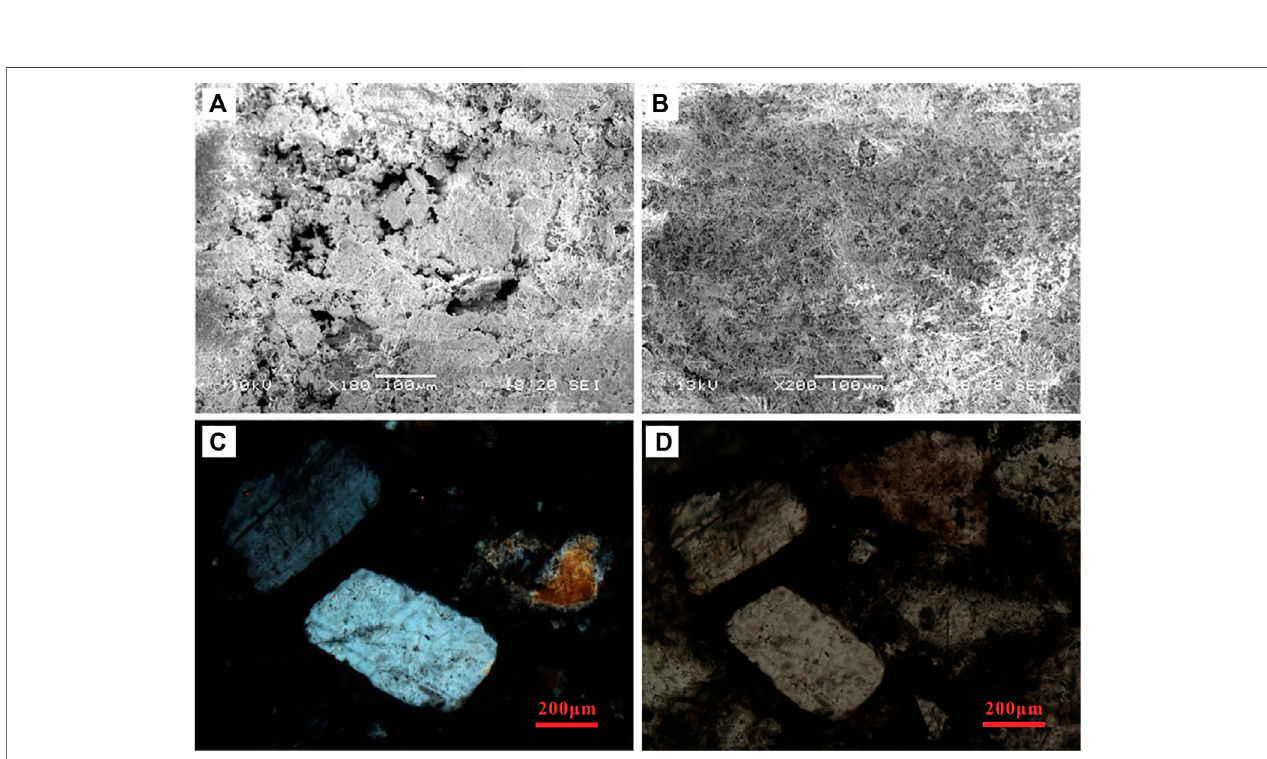
FIGURE 4 | Photos of microscope of morphology of polyhalite. (A) and (B) indicate the polyhalite in transition layer between layers of halite and clastic; (C) and (D) refer to the morphology of polyhalite in halite layer.